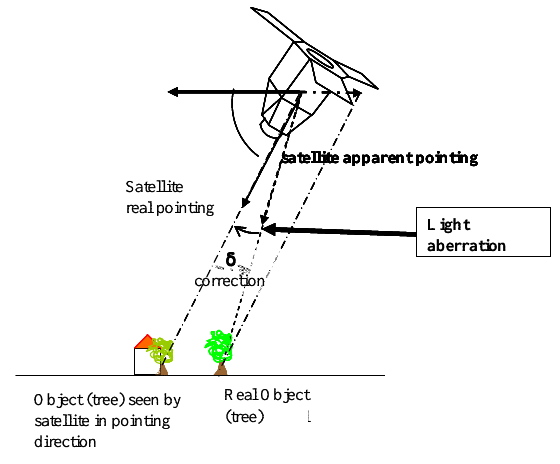
Figure 2: light aberration between satellite and ground The deviation depends on the viewing orientation U ( ) ( ) y y or pitch . x y Fig.3 shows the deviation magnitude versus roll and pitch angles. The maximum deviation is on Nadir acquisition and is around 25µrad.